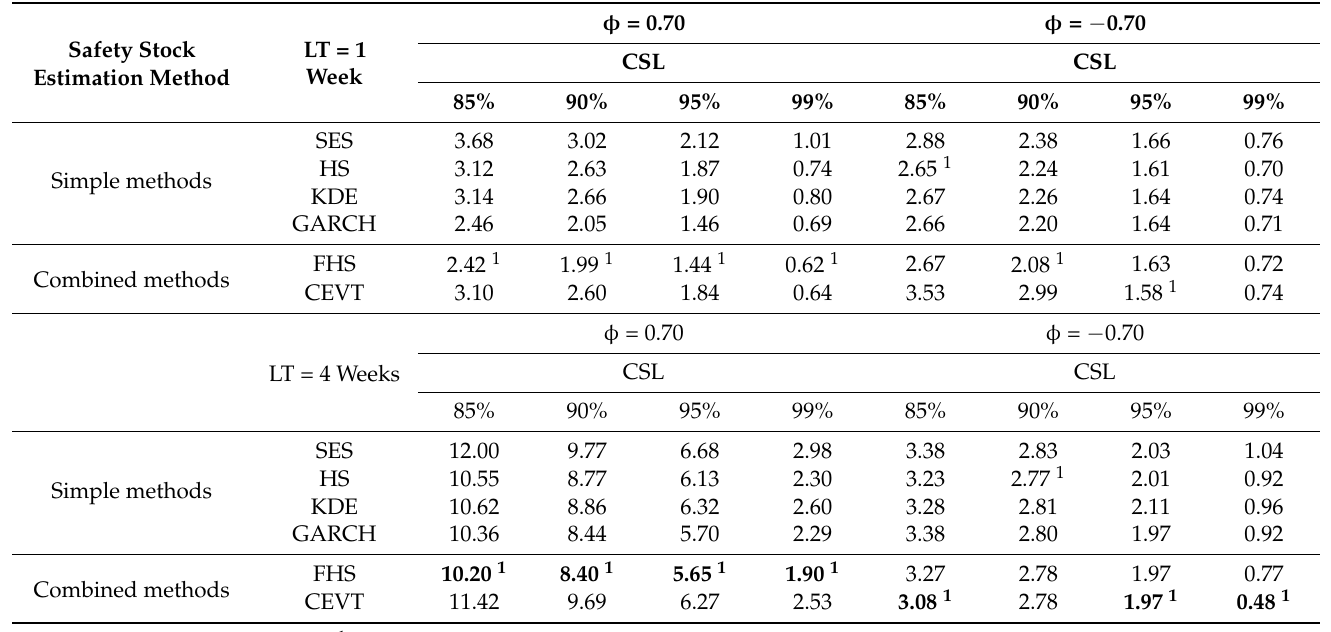
Table 2. Tick loss function values corresponding to φ = 0.70 and φ = − 0.70 when forecasting errors follow a lognormal distribution.